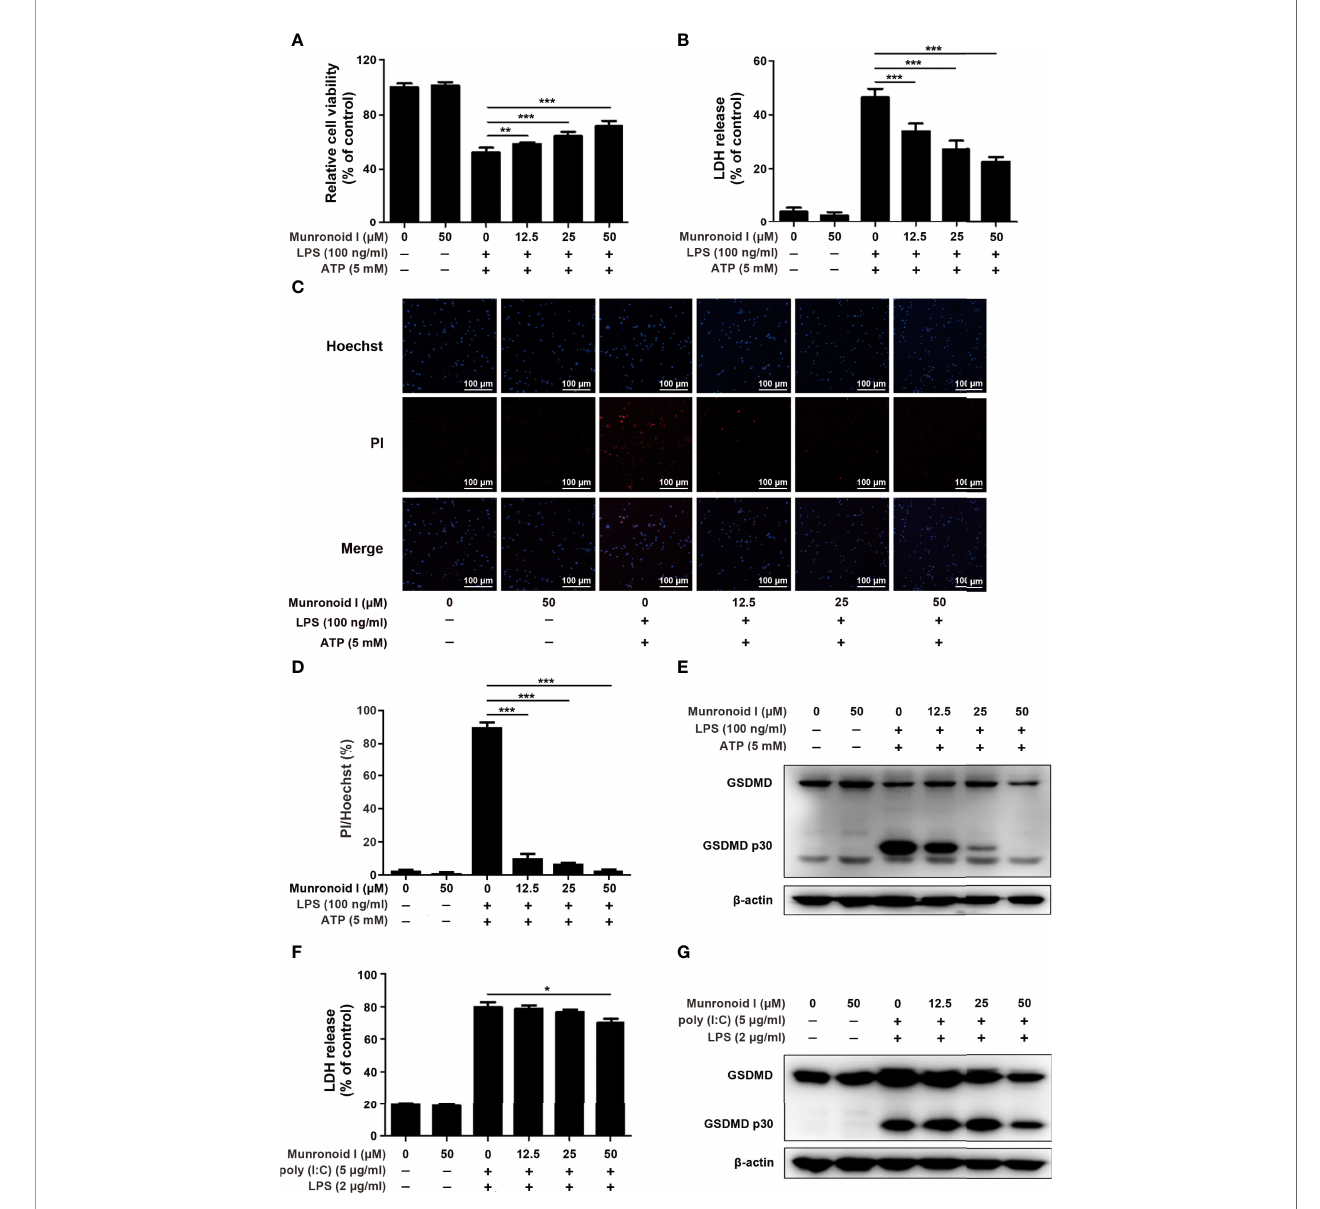
FIGURE 4 | Munronoid I suppresses LPS/ATP-induced activation of canonical pyroptosis pathway. (A, B) Mouse peritoneal macrophages were pretreated with DMSO or Munronoid I (12.5 m M, 25 m M, 50 m M) for 2 h, following LPS (100 ng/ml) stimulation for 4 h, and then treated ATP (5 mM) for 30 min. And the cells viability was detected by CCK-8 assay (A) . The supernatants were analyzed by LDH assay (B) . (C, D) Mouse peritoneal macrophages were pretreated with DMSO or Munronoid I (12.5 m M, 25 m M, 50 m M) for 2 h, following LPS (100 ng/ml) stimulation for 4 h, and then treated ATP (5 mM) for 1 h. Hochest33342 and PI double staining images were captured by fl uorescence microscopy (10×), merged with bright- fi eld images (C) . The ratio of Hoechst and PI was analyzed by Image J (D) . And GSDMD and p30 subunit were detected by Western blot (E) . (F, G) Mouse BMDMs were pretreated with DMSO or Munronoid I (12.5 m M, 25 m M, 50 m M) for 2 h, following poly I:C (5 m g/ml) stimulation for 4 h, and then LPS (2 m g/ml) was transfected into the cells for 16 h. The supernatants were analyzed by LDH assay (F) . GSDMD were detected by Western blot (G) . Data in A, B, D, and F presented as the mean ± SD of three independent experiments. *p<0.05, **p<0.01,